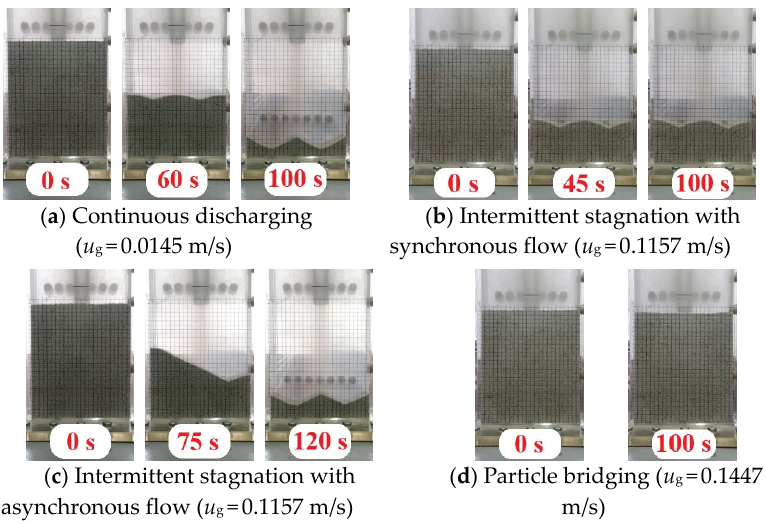
Figure 5. Different flow patterns under different gas superficial velocities ( D o = 15 mm, α = 0°).